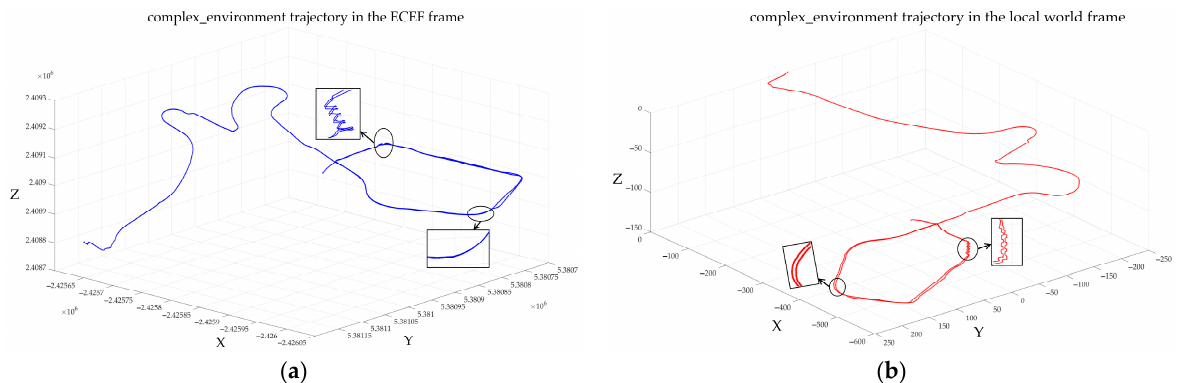
Figure 10. Comparison of the 3D trajectories represented in different frames. ( a ) is the ECEF frame and ( b ) is the local world frame.